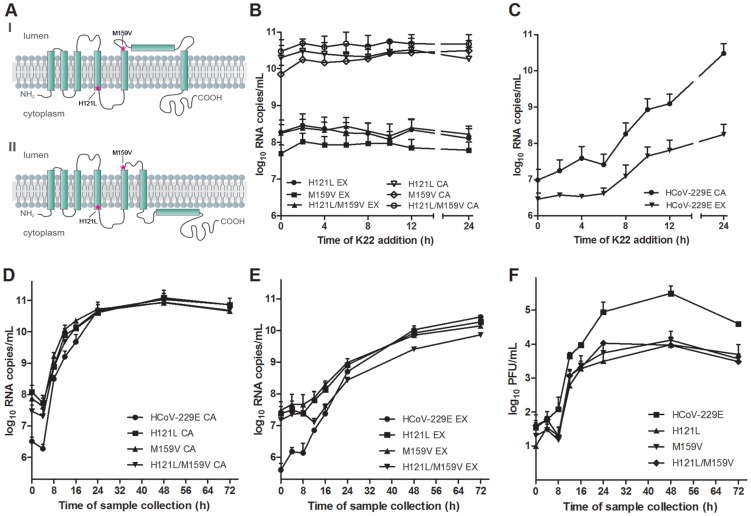
Analysis of recombinant HCoV-229E nsp6 mutants.(A) Predicted topological structure of HCoV-229E nsp6 indicating the location of K22 resistance mutations. Concerning transmembrane domains VI and VII two proposed topologies are shown. (B-C) Recombinant nsp6 mutant viruses are resistant to K22. MRC-5 cells were inoculated with nsp6 recombinant HCoV-229EH121L, HCoV-229EM159V, HCoV-229EH121L/M159V or wild-type HCoV-229E at a moi of 0.05 for 45 min at 4°C, and K22 (10 µM) was added at specific time points relative to the end of inoculation period. The infectious cell culture medium and cells were harvested after 24 h of incubation at 37°C, and copy numbers of cell-associated (CA) or extracellular (EX) viral RNA was determined. Data shown are means (±SD) of duplicate determinations from two independent experiments. (D-F) Replication kinetics of recombinant nsp6 mutant viruses. MRC-5 cells were inoculated with nsp6 recombinant HCoV-229EH121L, HCoV-229EM159V, HCoV-229EH121L/M159V or wild-type HCoV-229E at an moi of 0.05 for 1 h at 4°C. The infectious cell culture medium and cells were harvested at specific time points relative to the end of inoculation period, and copy numbers of cell-associated (CA; D) or extracellular (EX; E) viral RNA and infectivity (F) was determined. Data shown are means (±SD) of duplicate determinations from two independent experiments.